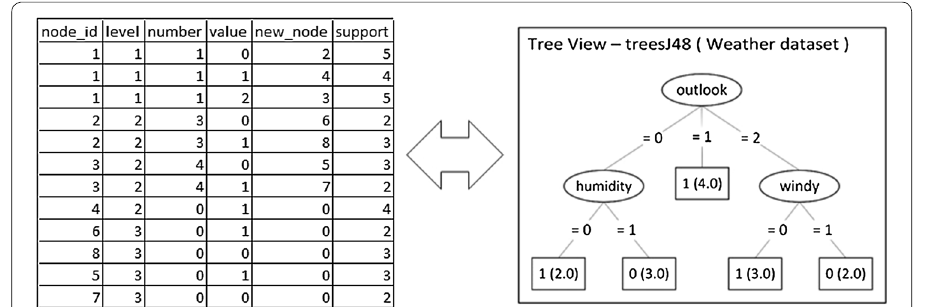
Fig. 15 Decision Tree model representation in HPCC. SplitD dataset—Decision